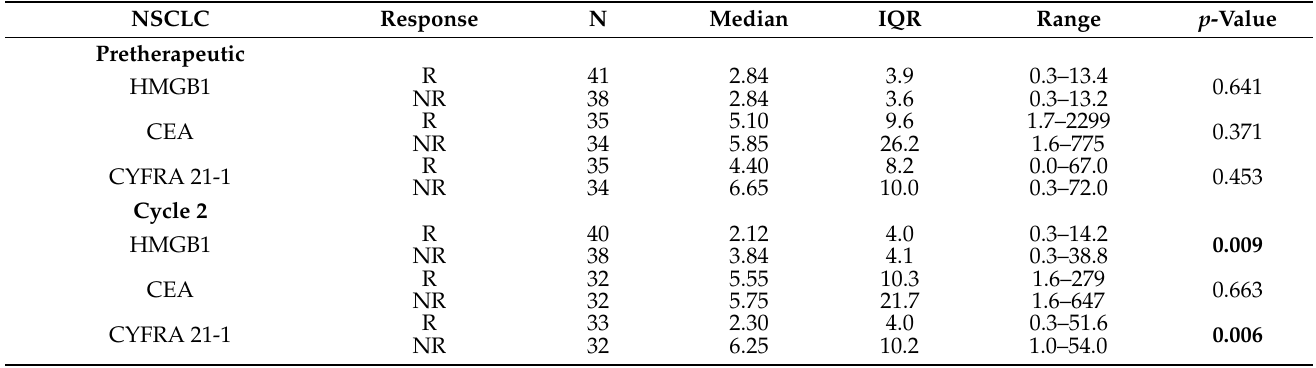
Table 2. Prediction of therapy response in NSCLC by